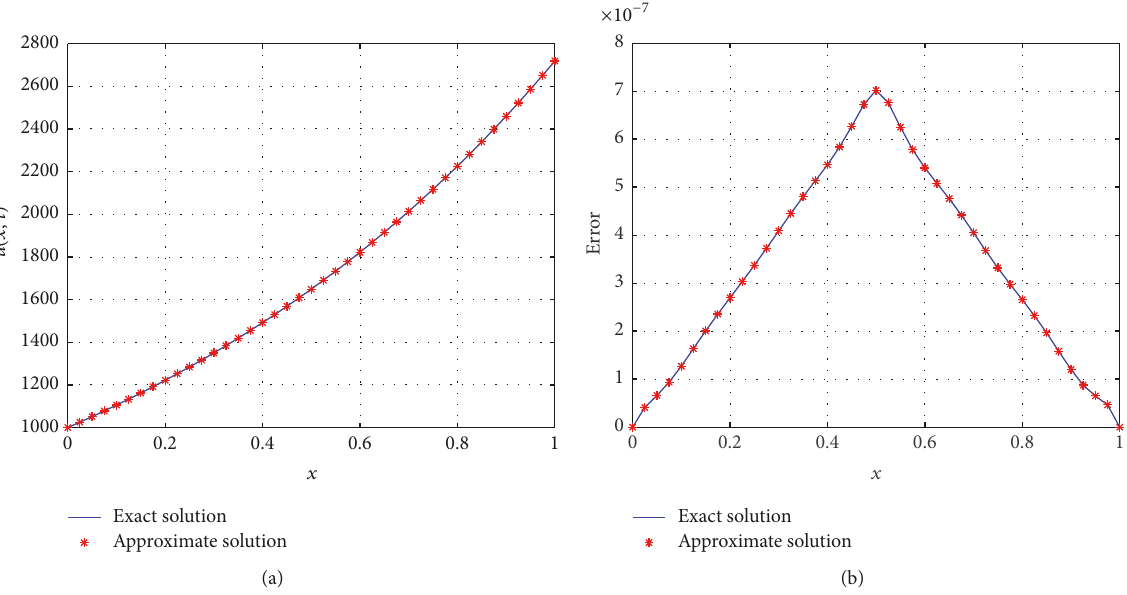
Figure 6: The exact and approximation solution (a) and corresponding error (b) at 𝑘 = 2 , 𝑀 = 6 , and 𝑇 = 10 .